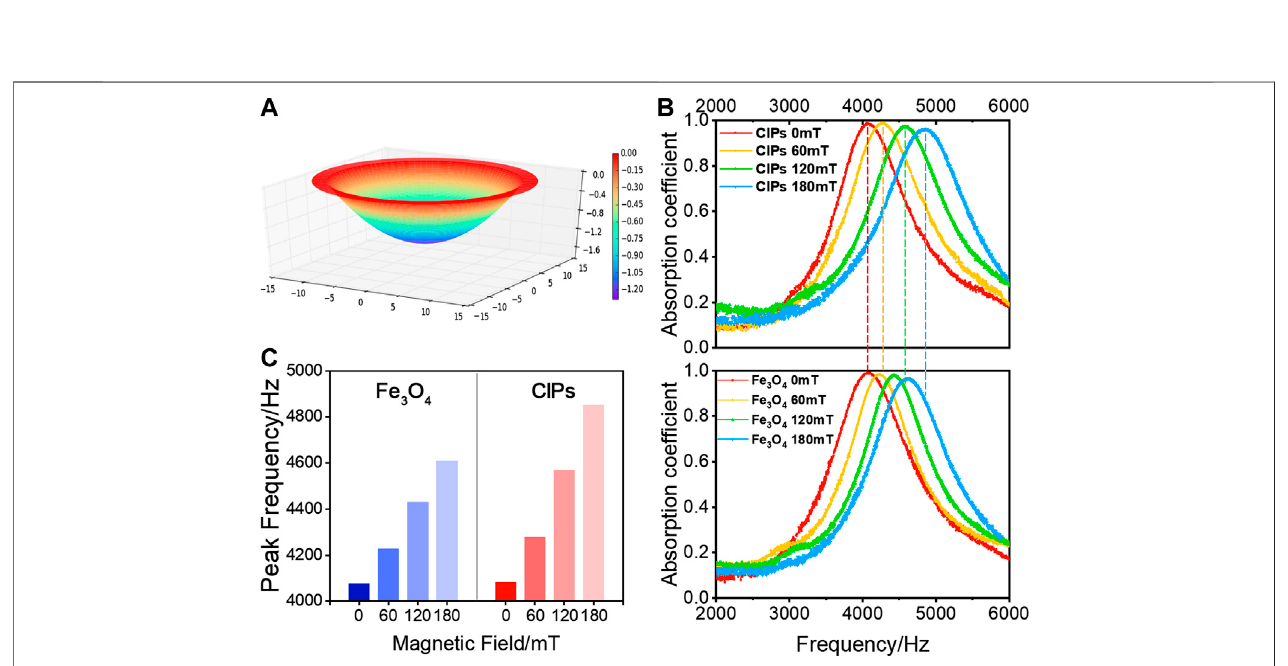
FIGURE 8 | Deformation and sound absorption properties of the Fe 3 O 4 -MRMs: deformation simulation diagram (A) , comparison of the sound absorption curves between Fe 3 O 4 -MRMs and CIP-MRMs (B) , comparison of the peak frequency between the Fe 3 O 4 -MRMs and CIP-MRMs (C) .